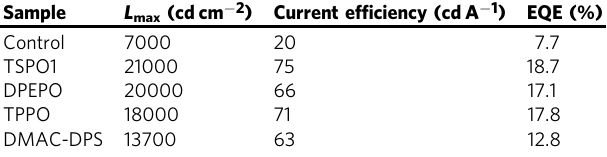
Table 1 Device performance for QLED with different passivation